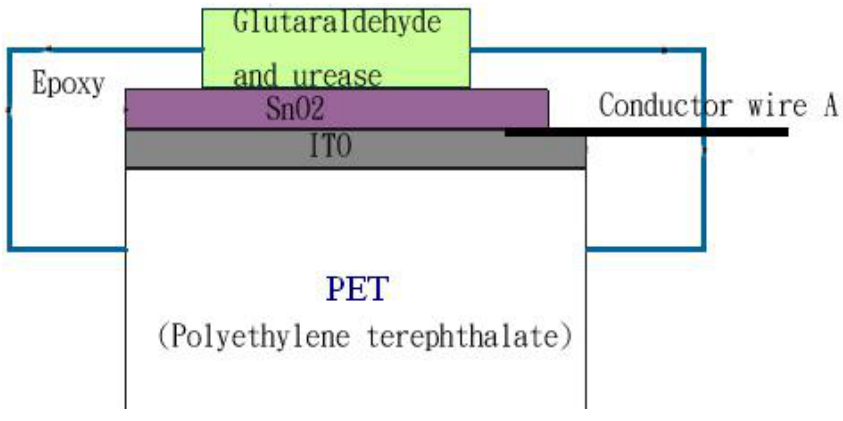
Figure 1. Electrode structure of ion-contact type.